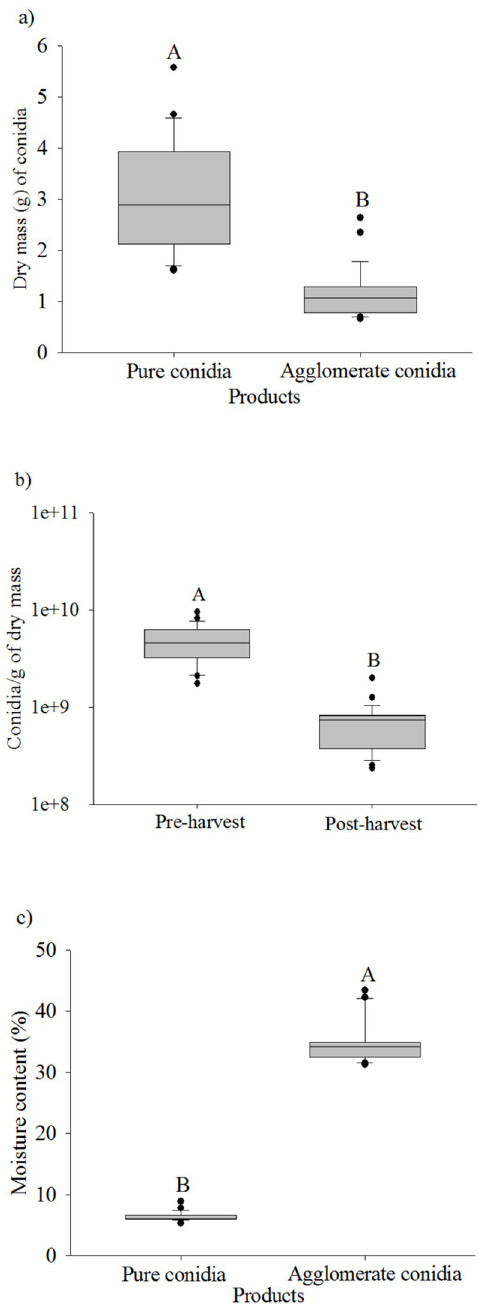
Fig 1. Evaluation of conidia harvest with Mycoharvester 1 System. a: Dry mass (g) of the pure and agglomerate conidia in 150g of colonized substrate (P < 0.0001). b: Water content of the pure and agglomerate conidia of Metarhizium anisopliae after harvesting the material (P < 0.0001). c: Performance of Mycoharvester 1 version 5b in the conidia harvest of Metarhizium anisopliae : Comparison of the substrate + fungus before and after the harvest procedure (P < 0.0001). Means followed by the same capital letter are similar by the Tukey-Kramer test at 5% significance level. Tween 80 (0.02%) [16]. Aerial conidia is the principal and most effective infectious stage of the entomopathogenic Hypocreales [32] and the ease of production of pure conidium in the